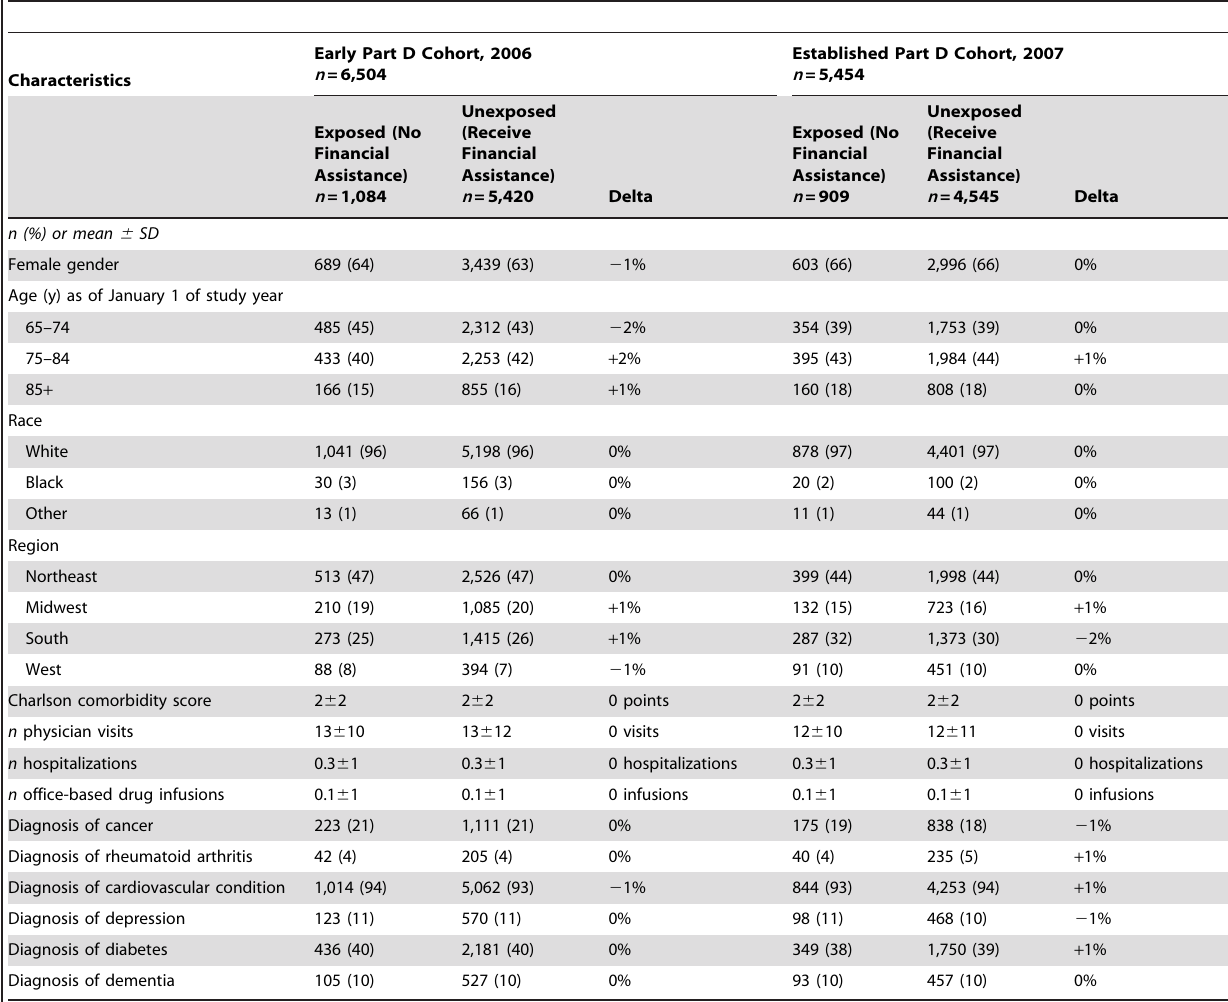
Table 2. Characteristics of multivariate propensity score-matched beneficiaries who reached the coverage gap spending threshold in the Early Part D cohort, 2006, or the Established Part D cohort,